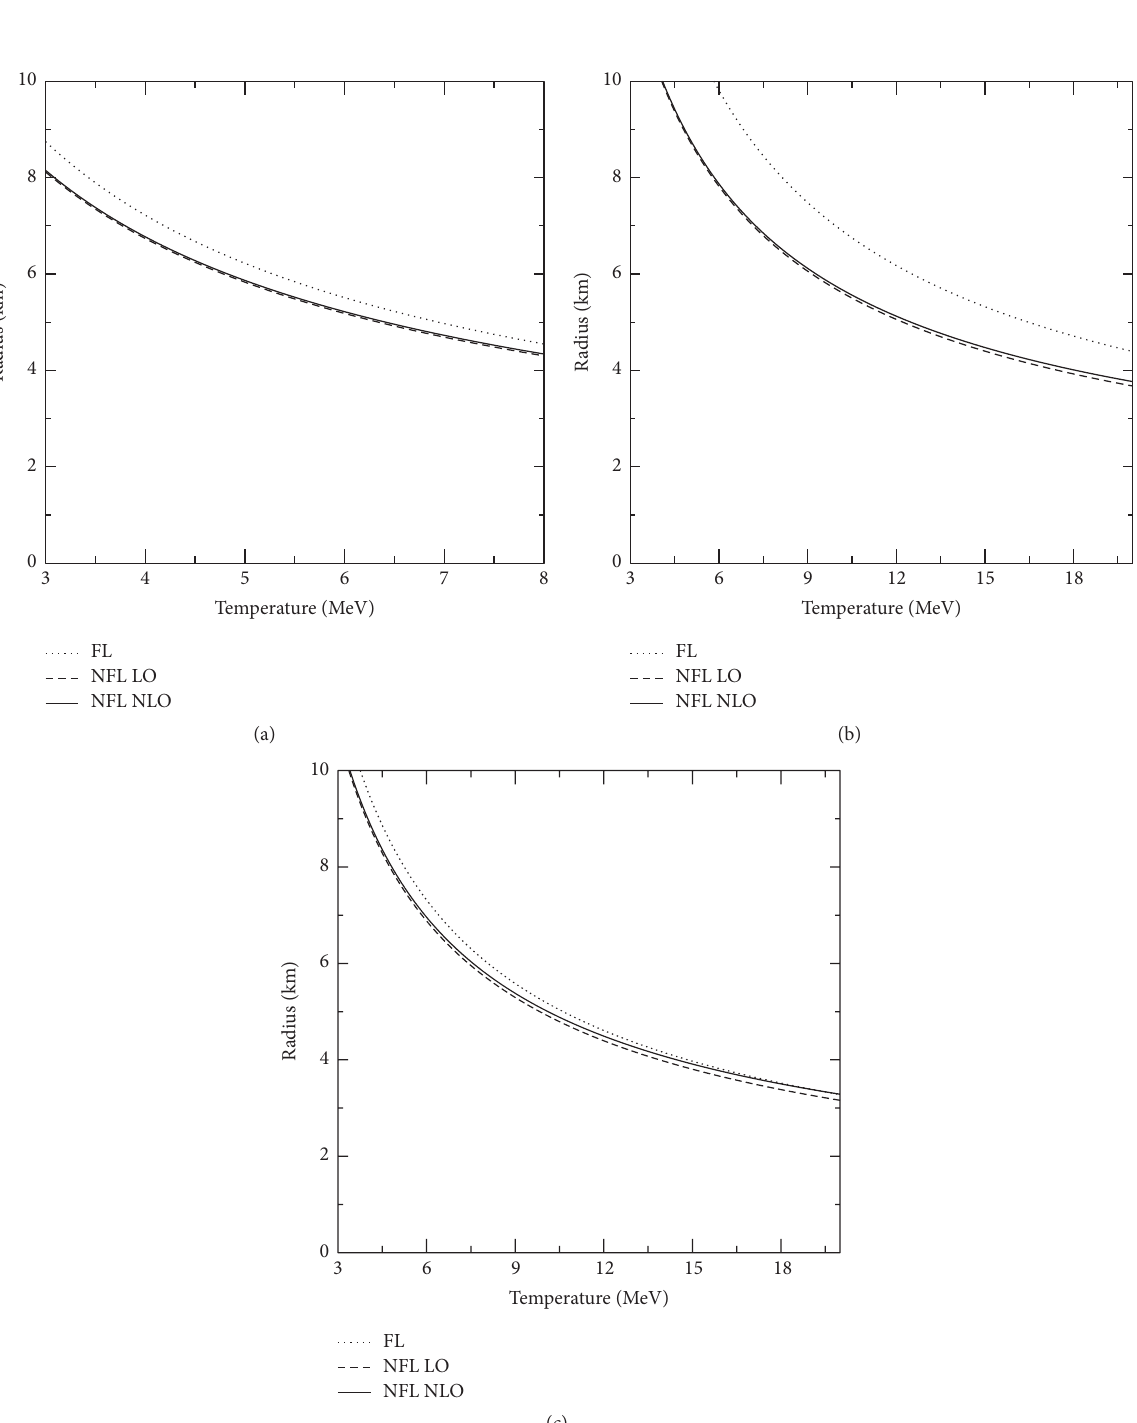
Figure 4: The comparison of the relationship (FL, LO, and NLO, resp.) where high magnetic field (𝐵 = 10 19 G ) has been taken into account along with vanishing temperature for kick velocity of 100 km / s has been shown in (a). (b) shows the corresponding case when high magnetic field effect in specific heat is included. (c) shows the comparison between the FL, NFL LO, and NFL NLO result for the radius and temperature dependence for partially polarized electrons in the presence of weak magnetic field (𝐵 = 5 × 10 15 G ) for kick velocity of 100 km /